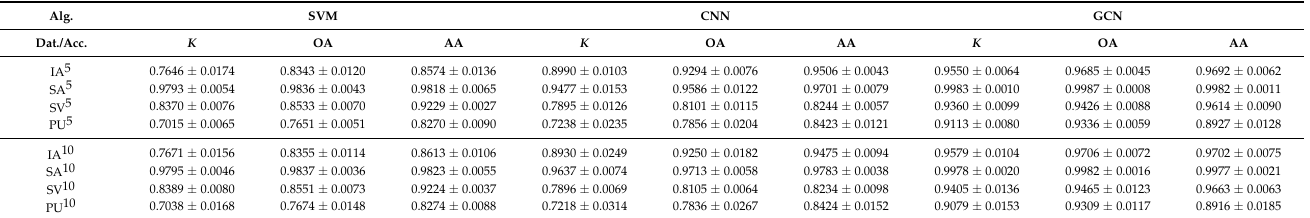
Table 2. The statistical classification accuracies for four real hyperspectral datasets with 5 and 10 random runs. Note that the experiments regarding a different number of random runs were carried out independently. Alg. SVM CNN GCN Dat./Acc. K